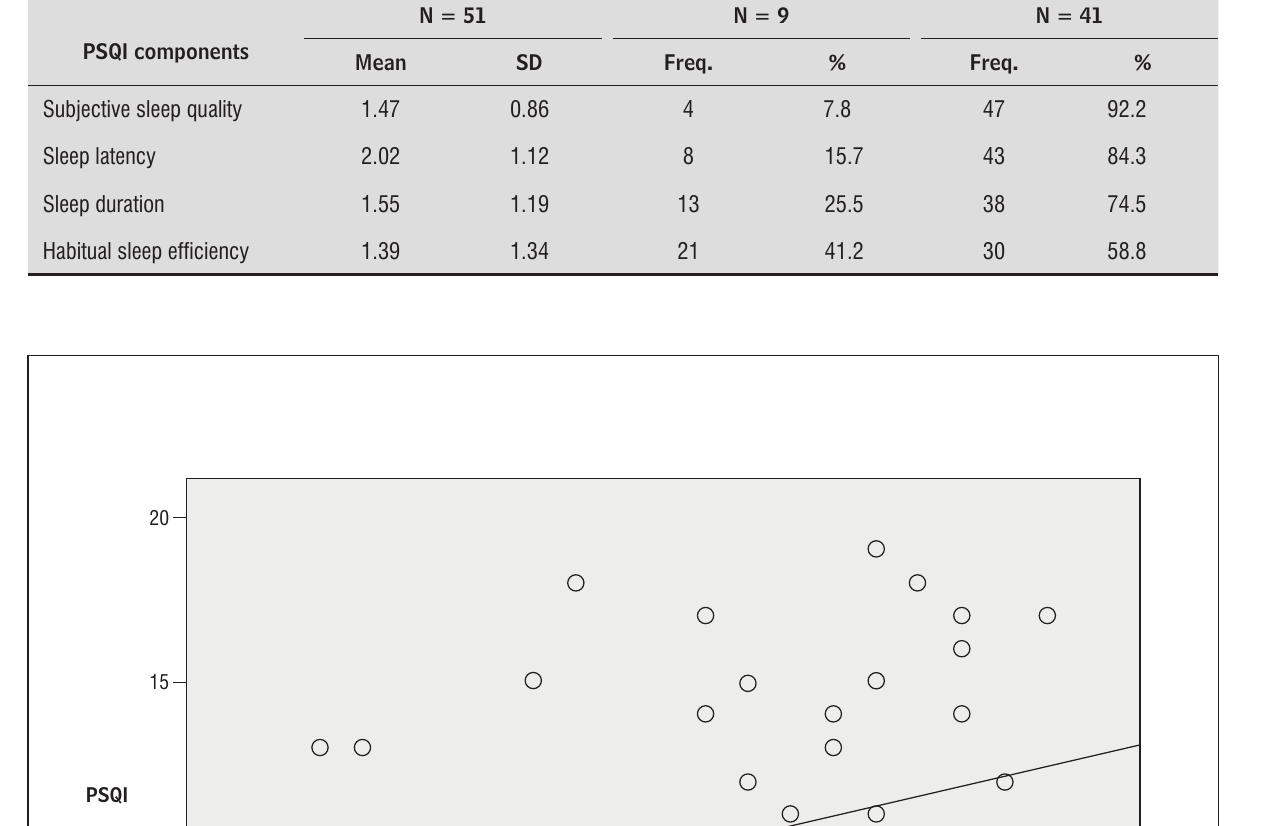
PSQI components Subjective sleep quality